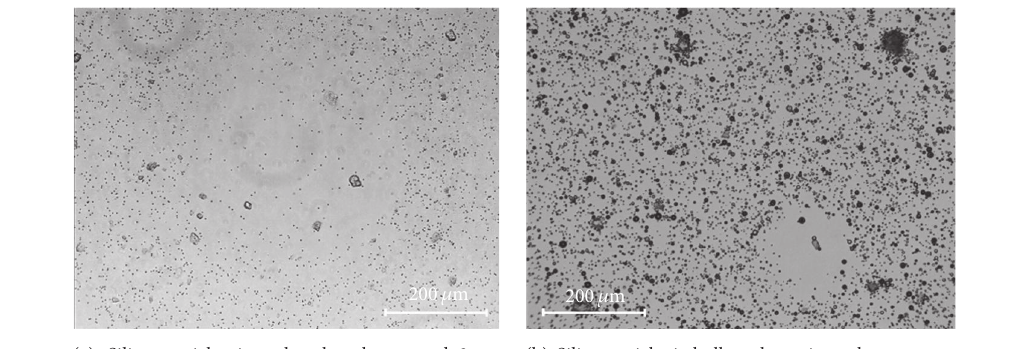
Figure 7: Clear zones, free of microspheres, were generated around single Silica particles in microsphere suspensions of various types, but smaller and rarer than around QELBY